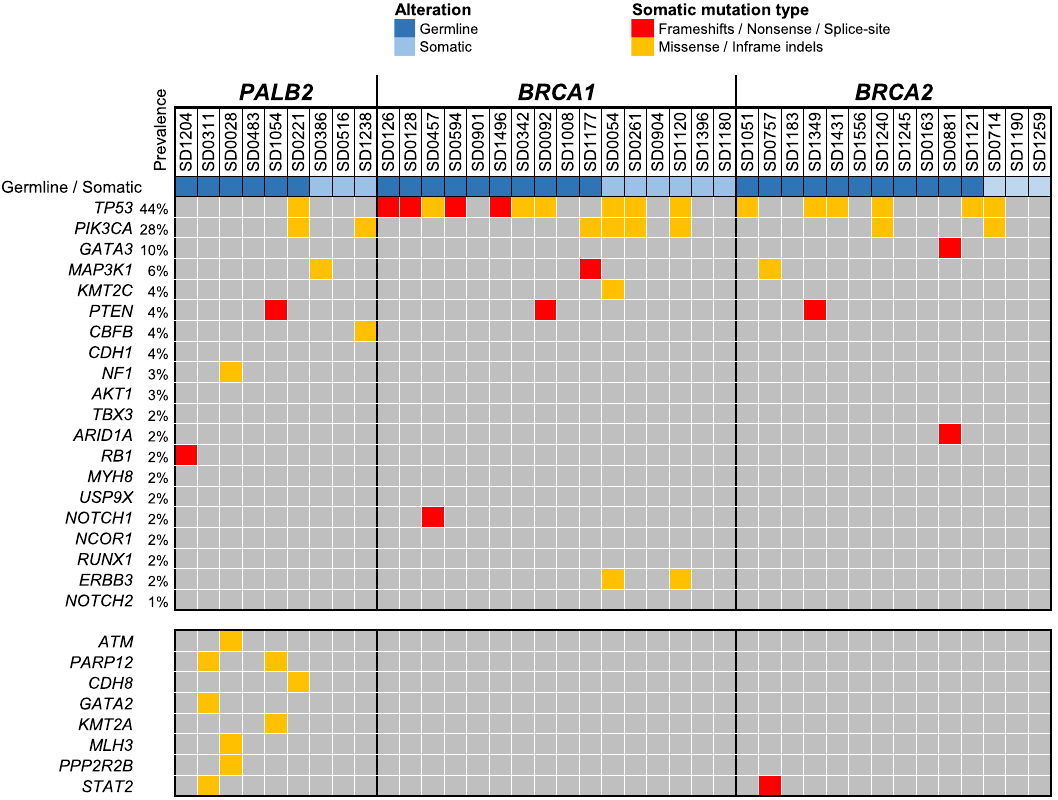
Fig. 3 The oncoplot shows all the somatic mutations identi fi ed in PALB2 tumours in comparison to BRCA1 and BRCA2 tumours in the top 20 mutated genes commonly associated with breast cancer (with prevalence indicated as reported previously by 18 ). The lower bottom panel represented somatic alterations in PALB2 tumours identi fi ed in other additional genes. Each column represented a